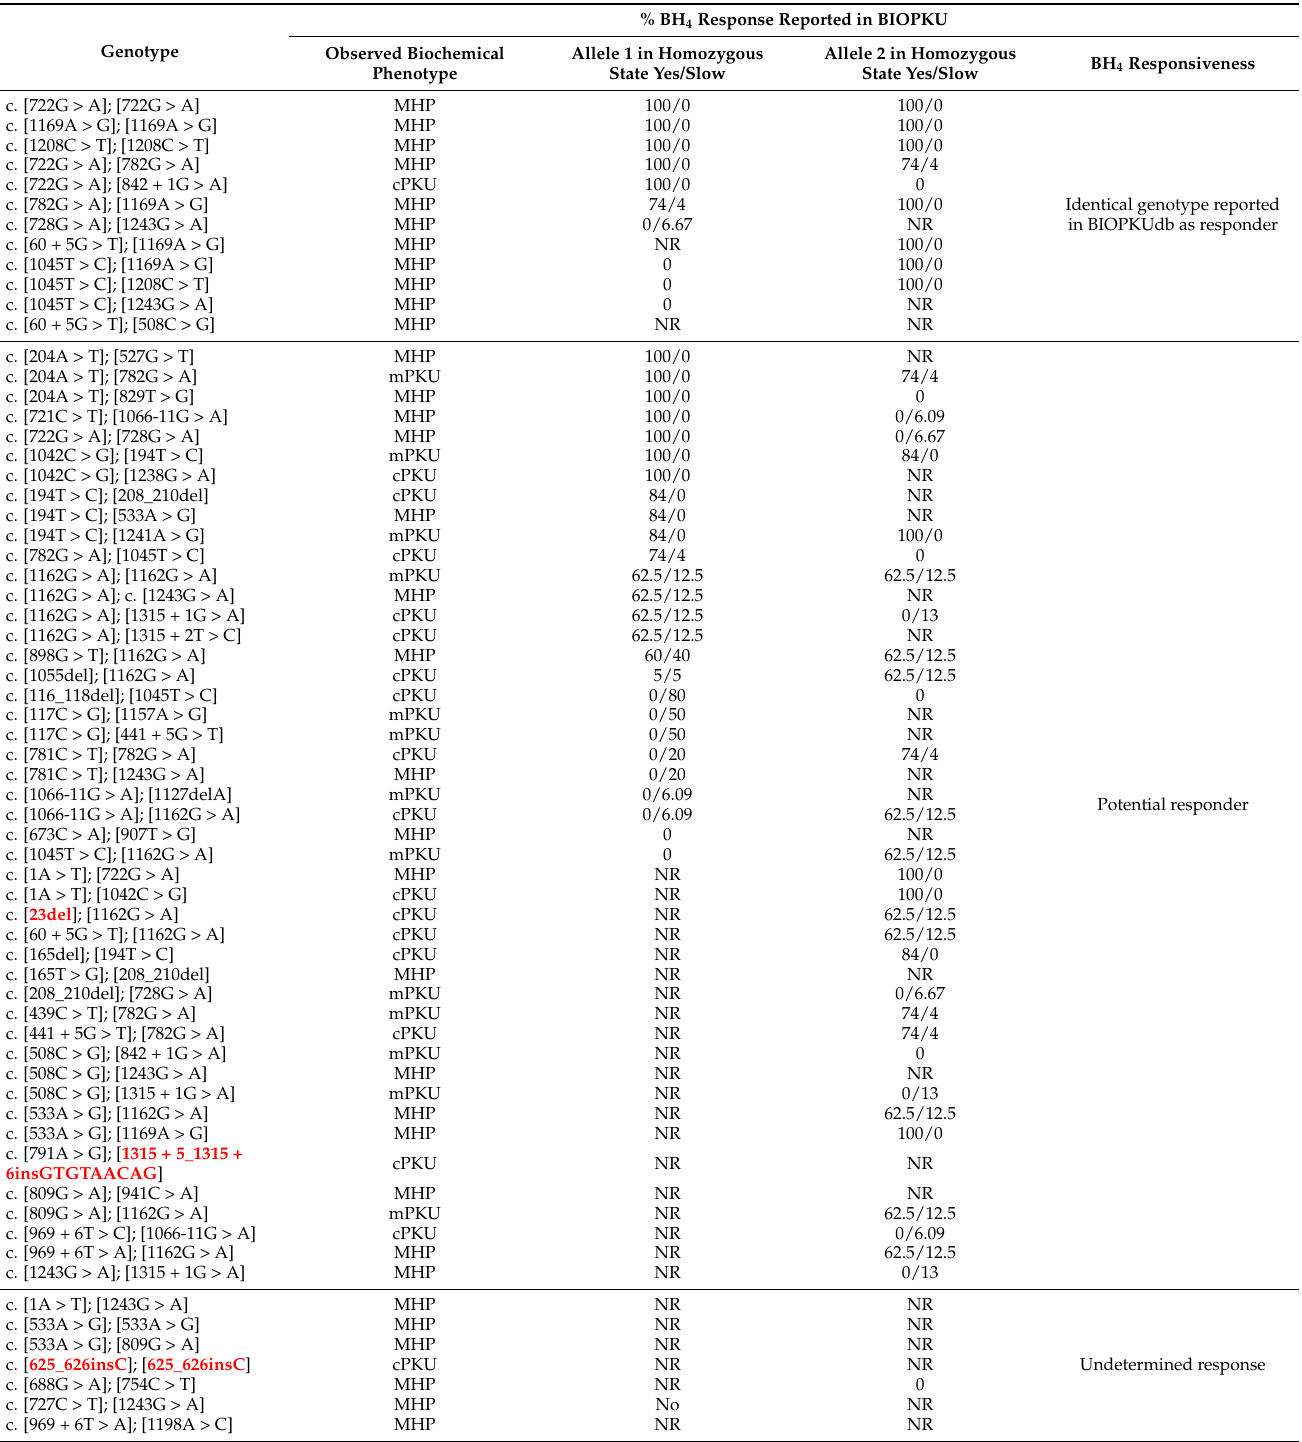
Table 4. Potential BH 4 -responder patients (65/124, 52%) according to their genotype, and those who were recommended for the BH 4 -responsiveness